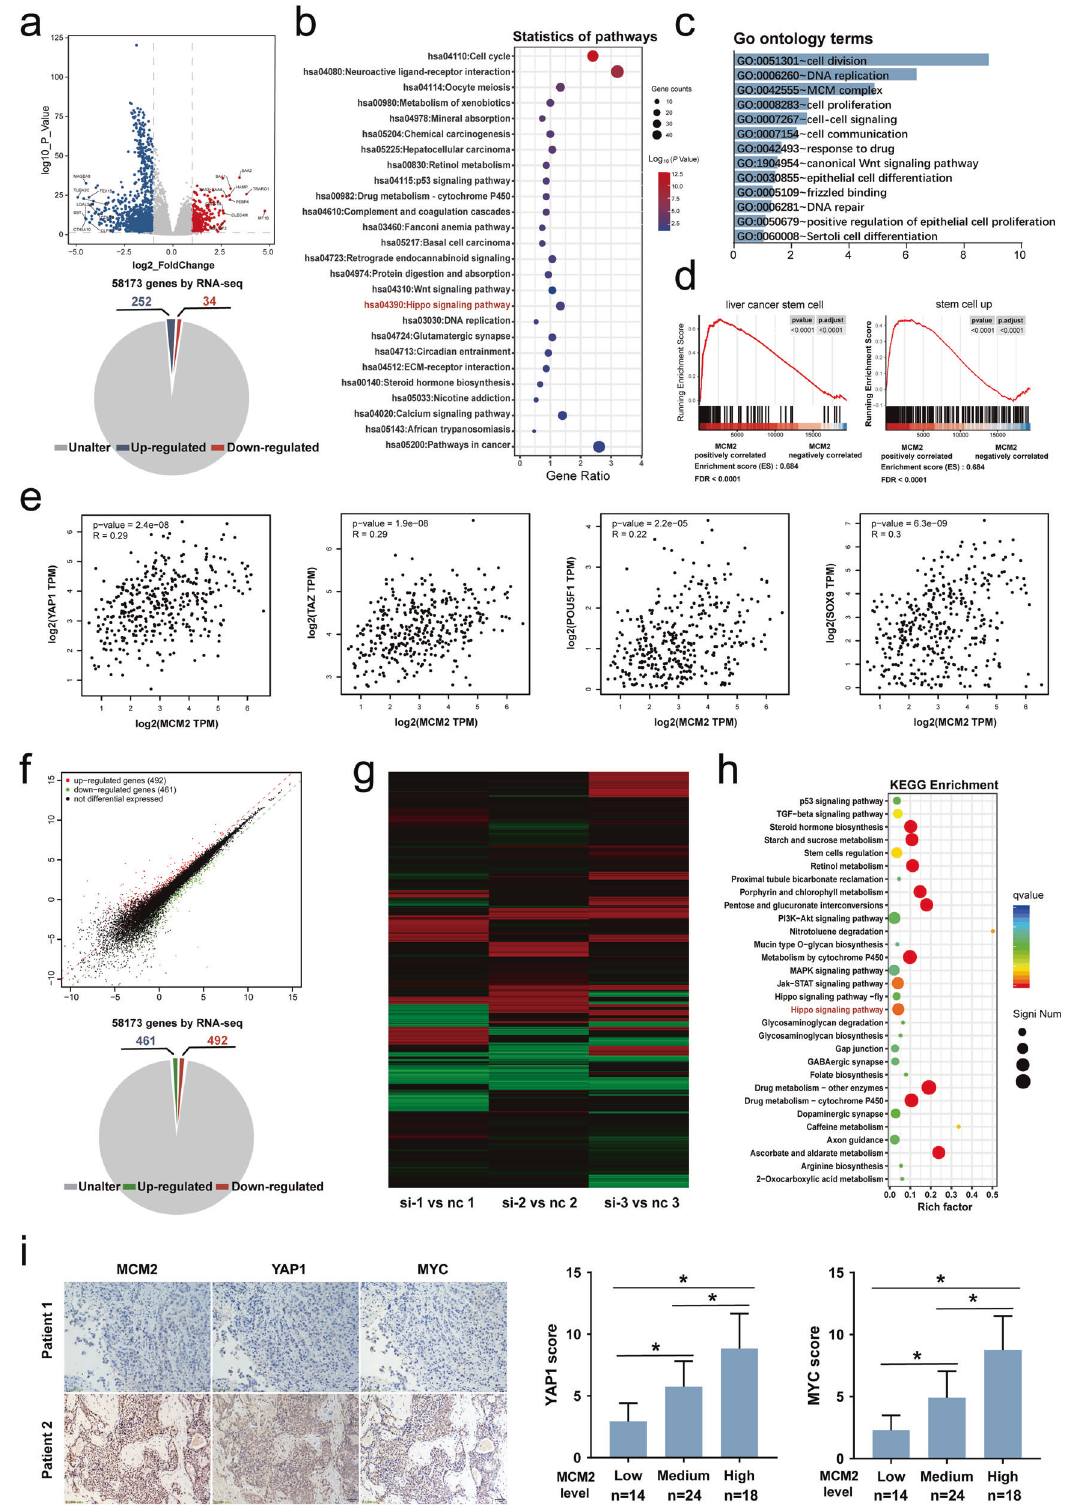
stemness-related molecules were further examined. The qPCR assays con fi rmed that the suppression of MCM2 caused a decrease in the expression of AKT1, Epcam, CD133, MYC, ALDH1A1, BMI1, and SOX9 in the MHCC-97H and Huh7